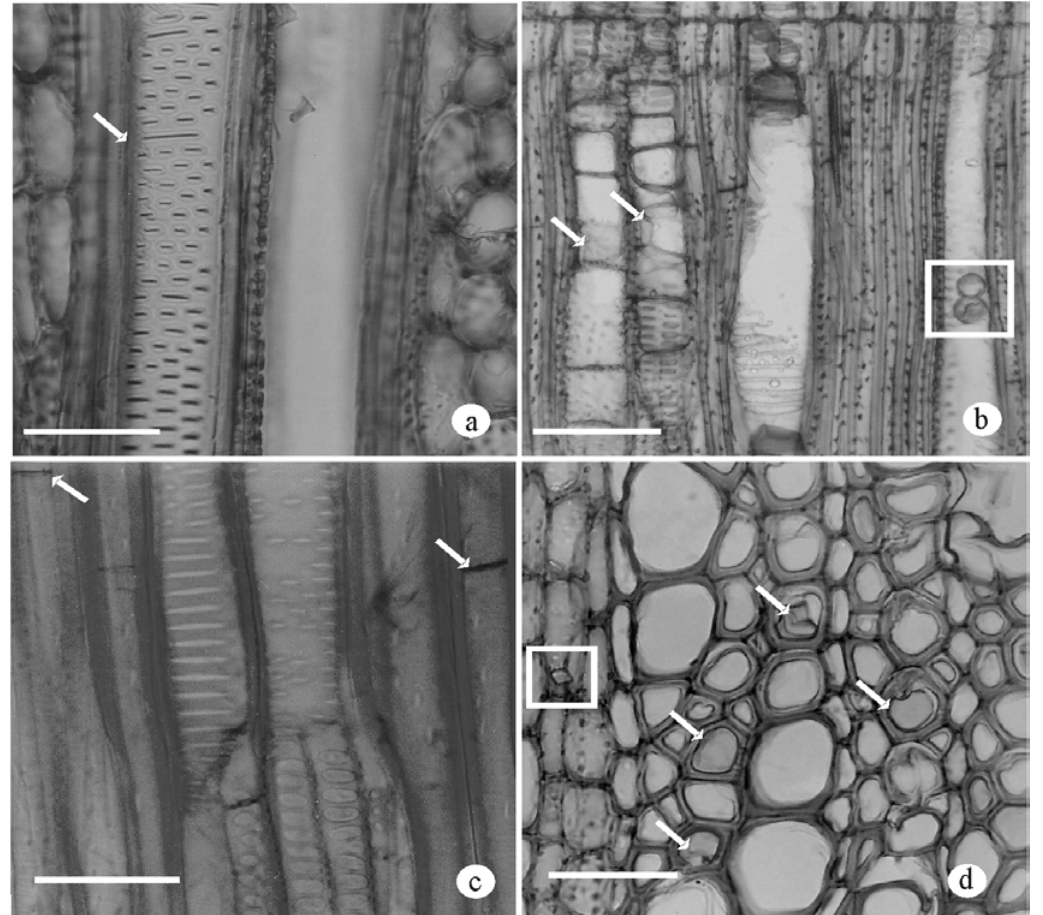
Fig. 3 – Mollinedia glabra wood. a. Details of intervessel pits scalariform to opposite (arrow) of OPS (TLS). b. Tyloses lightly sclerosed (arrows) and common tyloses (square) of OPS (RLS). c. Fiber-tracheids septate (arrows) of OPS (TLS). d. Fiber-tracheids (arrows) and presence of prismatic crystal (square) SSCS (CS). Bar = 50 μ m (a, d); 100 μ m (b,